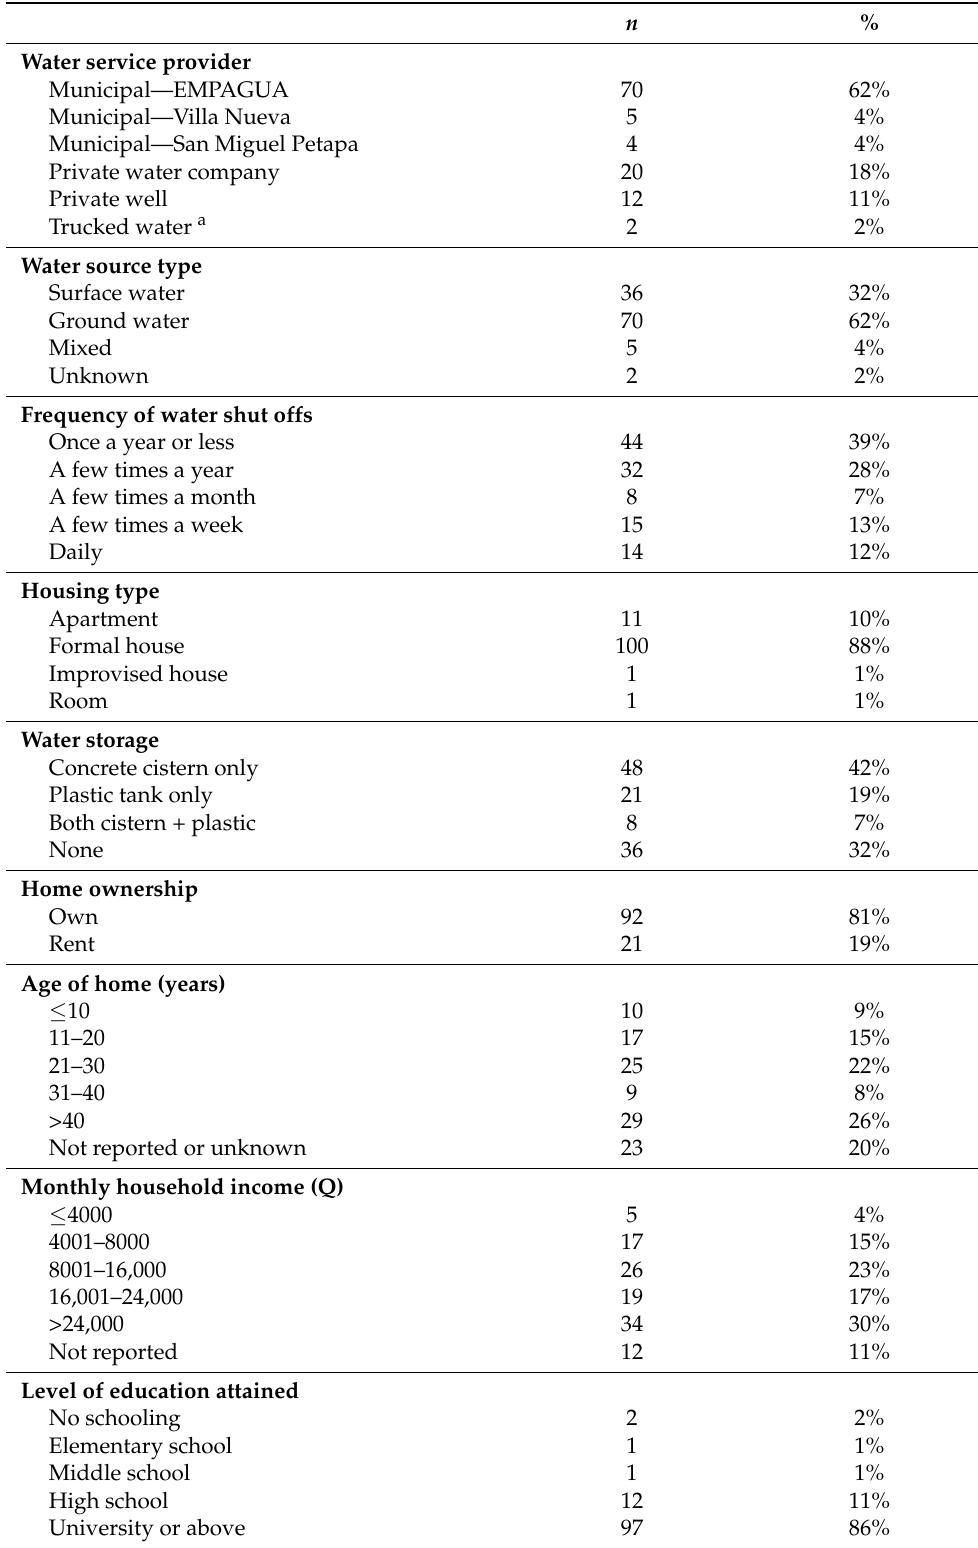
Table 1. Water service and household characteristics of the study population (total n =